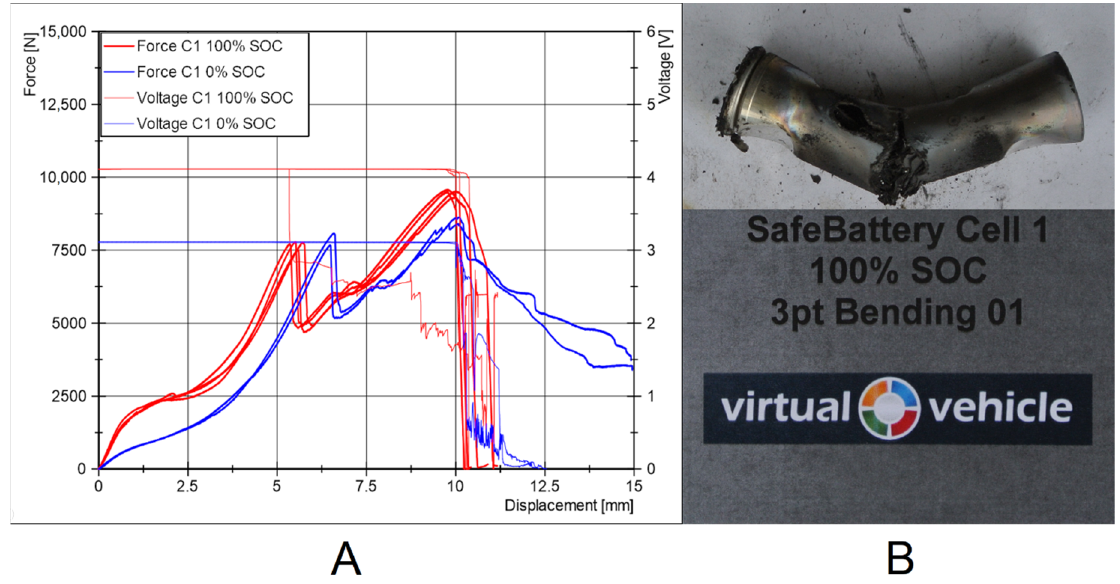
Figure A5. Three-point bending C1 (SOC comparison) force over displacement ( A ) and cell specimen after testing ( B ).